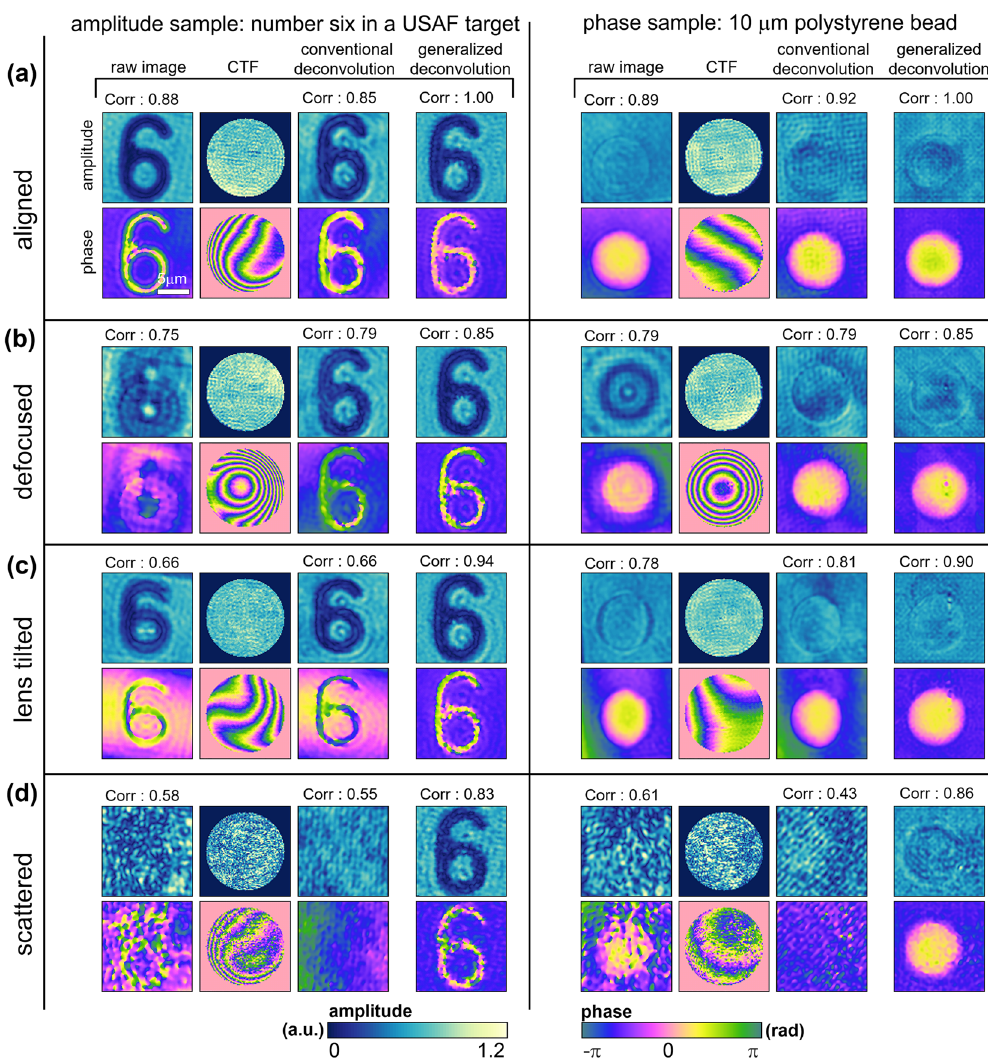
tical point of view, if the FOV of an imaging system can be divided into small sections where the shift invariance